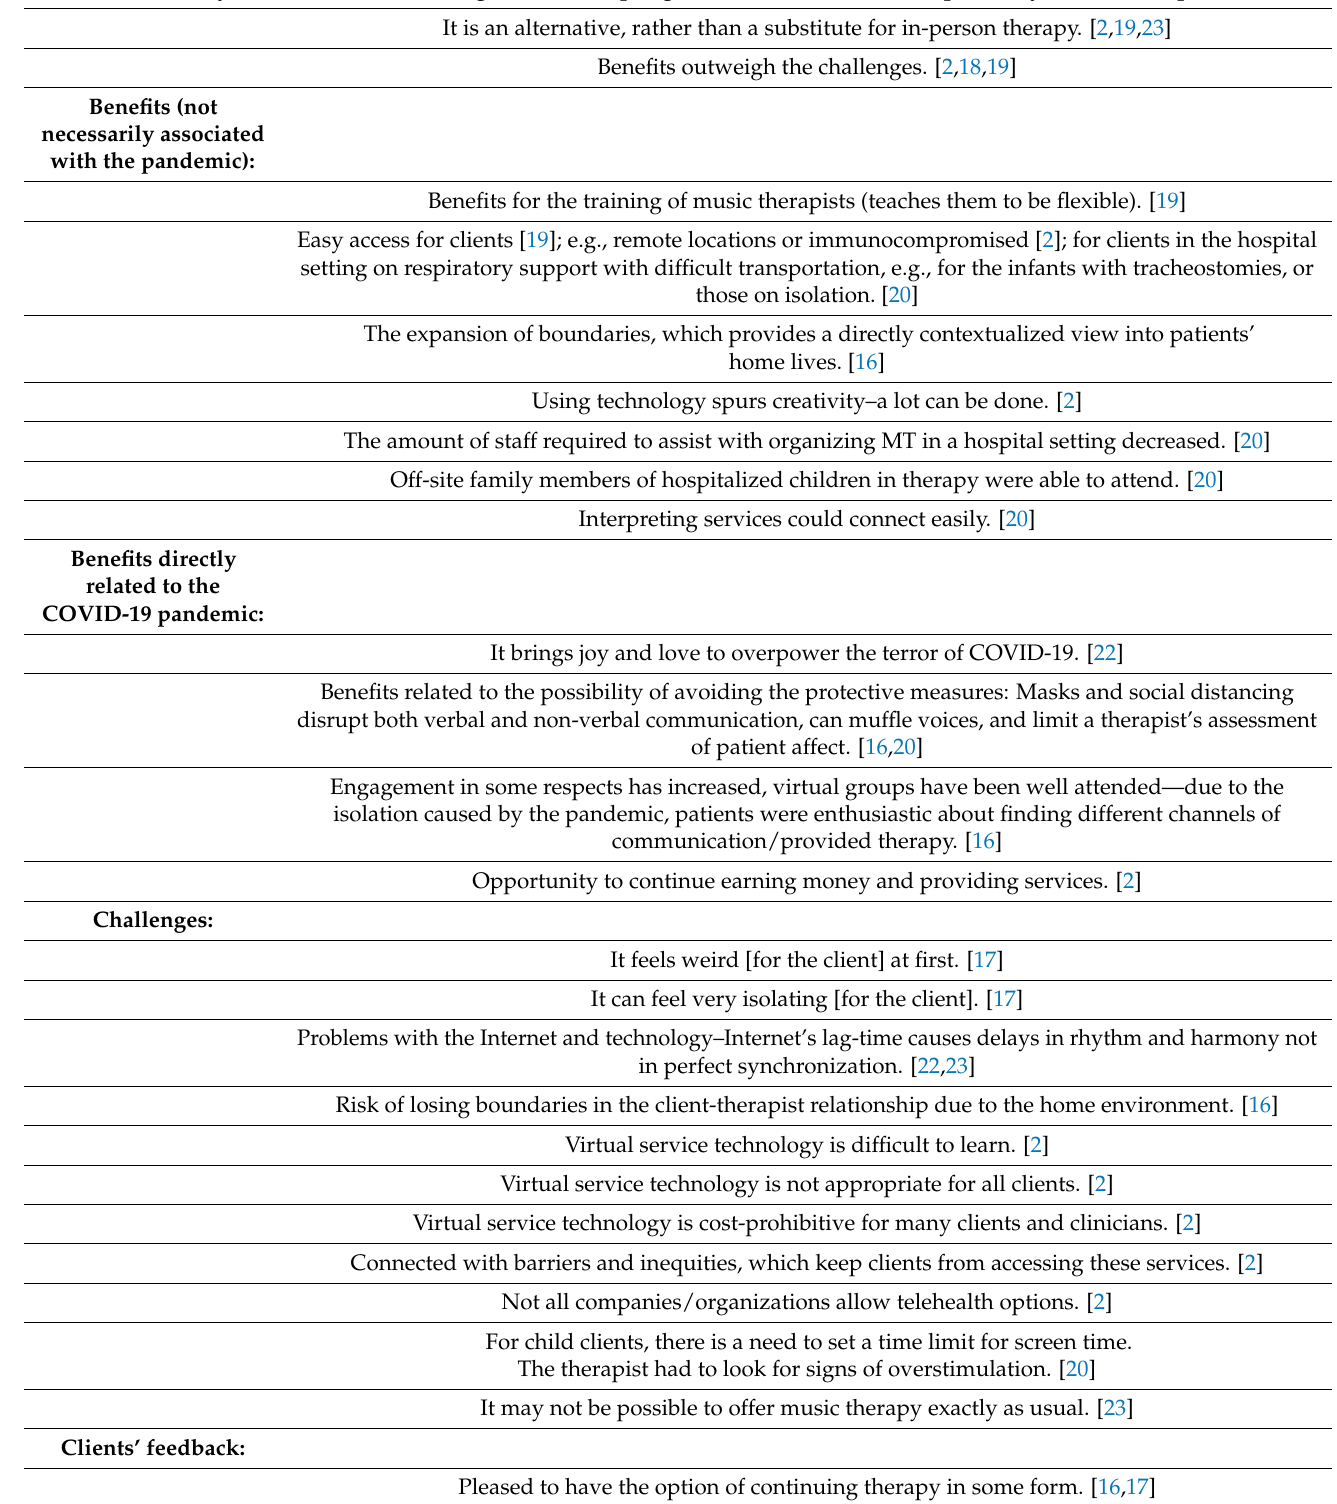
Table 3. Summary of benefits and challenges when adapting to remote sessions, as reported by music therapists. Summary of Benefits and Challenges when Adapting to Remote Sessions, as Reported by Music